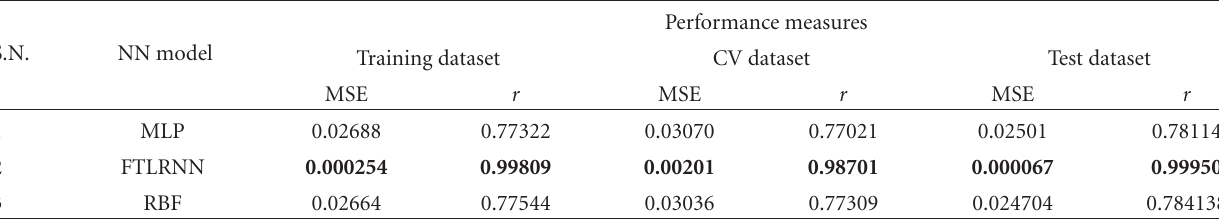
Table 14: Regression performance of NN models on EMG noise signal.